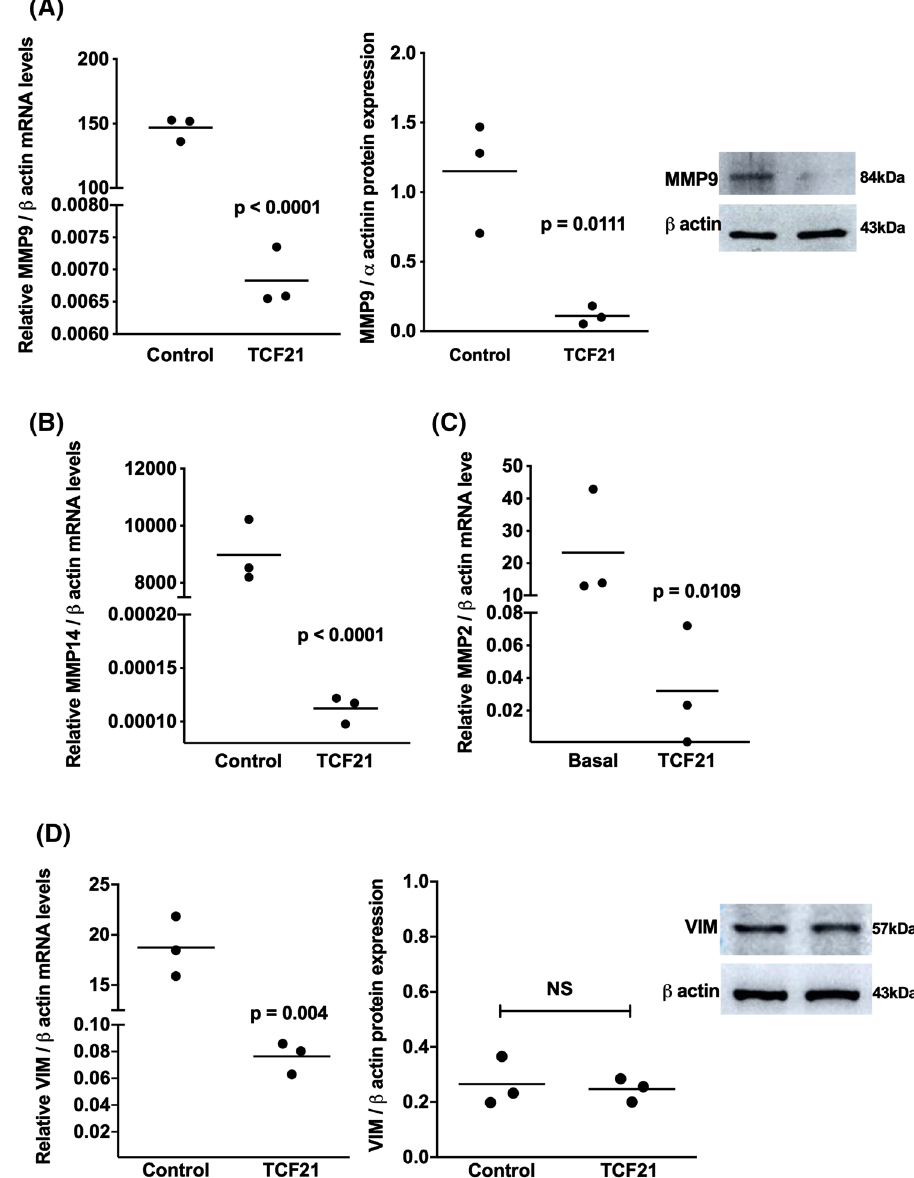
Fig. 6 TCF21 downregulated the invasive effectors in ACC cells. A Relative mRNA level and protein expression of metalloproteinase 9 (MMP-9) and representative immuno- blot; B Relative mRNA level of metalloproteinase 14 ( MMP- 14 ); C Relative mRNA level of metalloproteinase 2 ( MMP-2 ), D Relative mRNA level and protein expression of Vimentin (VIM) and representative immunoblot in H295R/ TCF21 cells and respective controls. The experiments were performed in triplicate and repeated three times. The results were expressed as the mean ± SD. Statistical significance was assessed by unpaired t